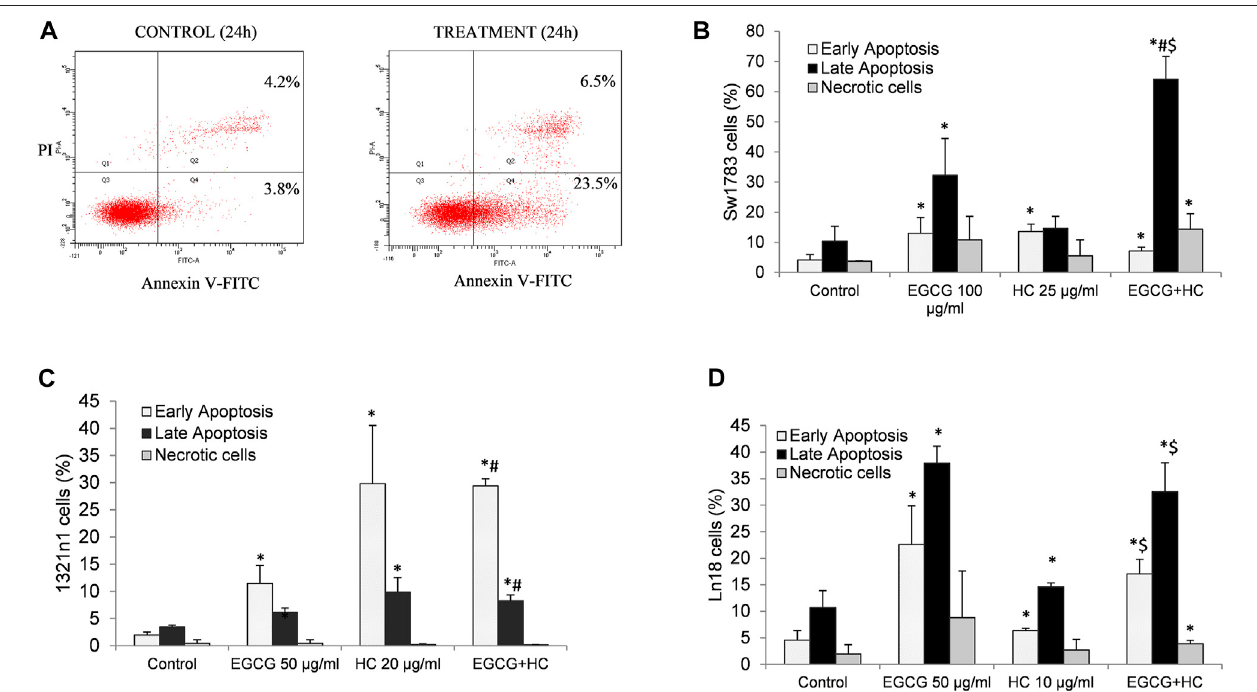
FIGURE4|(A) FlowcytometrydetectionofapoptosisfollowingannexinV-FITC/propidiumiodide(PI)labelling.Thelowerleftquadrant(Q3)containsviablecells,the lower right quadrant (Q4) contains early apoptotic cells, the upper right quadrant contains late apoptotic cells, and the upper left quadrant contains non-viable necrotic cells(Q1).Abargraphdisplayingthemeanvaluesfromthreeindependentexperimentsfor (B) 1321N1, (C) SW1783,and (D) LN18.* p < 0.05comparetocontrolearlyor late apoptosis respectively, # p < 0.05 compare to EGCG early or late apoptosis respectively, $ p < 0.05 compare to HC early or late apoptosis respectively.